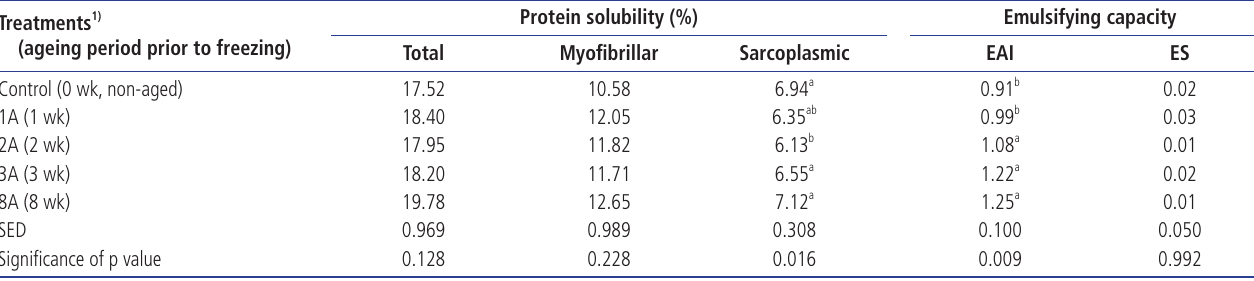
Table 2. Protein solubility and emulsifying capacity of meat batter formulated with aged/frozen/thawed lamb loins Treatments 1) (ageing period prior to